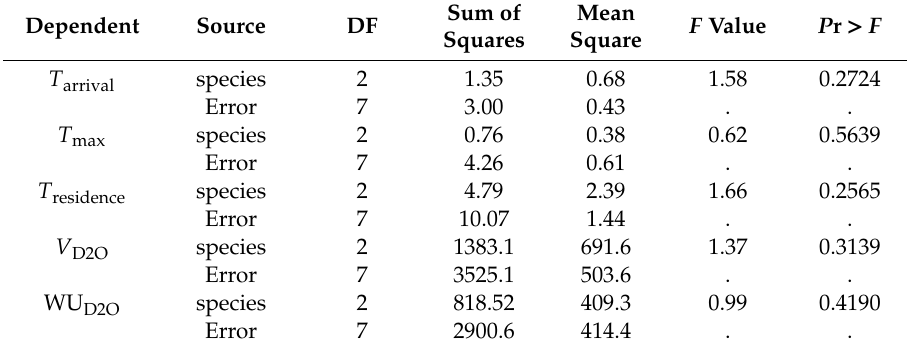
. . Table A2. Result of the analysis of variance (ANOVA) among the unbalanced data. The tested water transport characteristics based on deuterium tracing on four culms for B. vulgaris and three culms for G. apus and D. asper : times when deuterium arrived in the canopy ( T arrival , days), reached the maximum concentration ( T max , days) and amount of time it remained in the bamboos ( T residence , days). Derived daily water use (WU D2O , kg day − 1 ) and daily sap velocity ( V D2O , m day − 1 ). ‘ P > 0.05 ( P r > F )’ indicate equal variance among species.